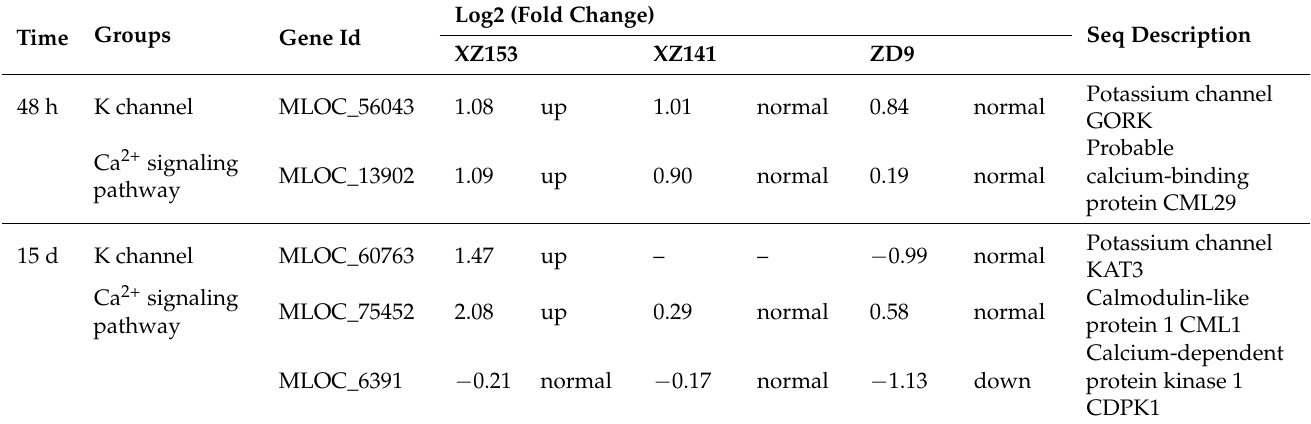
Table 1. The DEGs involved in K + channels and Ca 2+ signaling pathway at 48 h and 15 d after LK